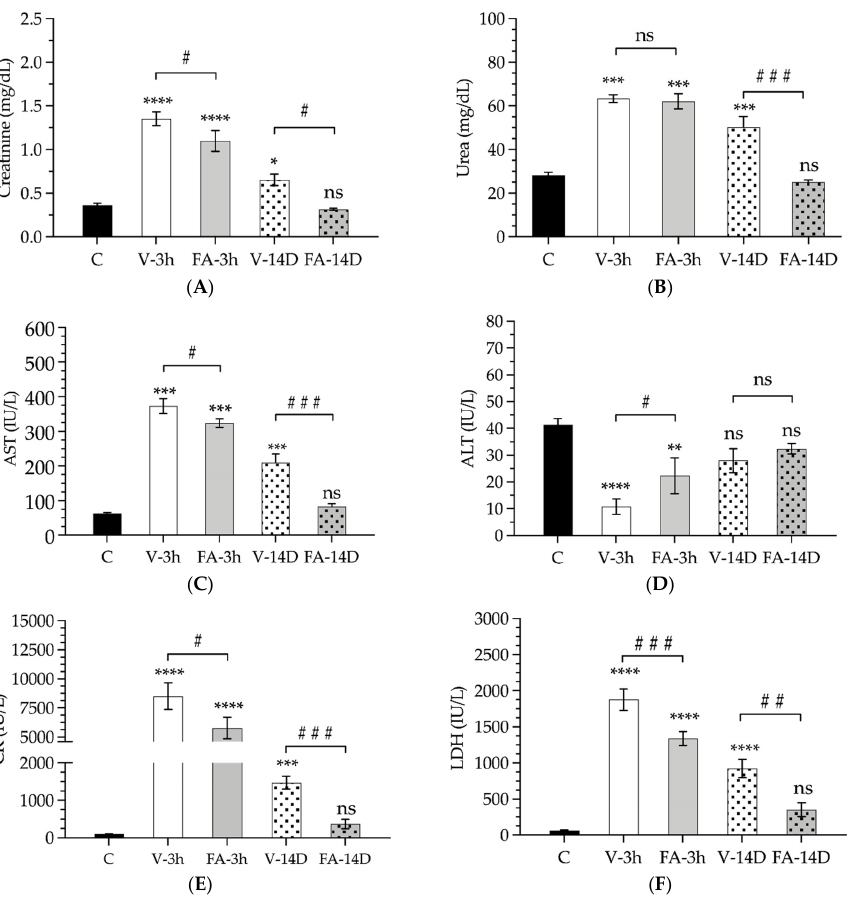
Figure 1. Enzyme and electrolyte levels detected in the serum samples collected from the control animals (C, black bar) or animals subjected to ischemia after a period of 3 h or 14 days of reperfusion and treated with folinic acid (FA-3h, smooth gray bars; FA-14D, smooth gray bars) or treated with saline (V-3h, smooth white bars; V-14D, smooth white bars): creatinine ( A ), urea ( B ), aspartate transaminase (AST) ( C ), alanine transaminase (ALT) ( D ), creatine kinase (CK) ( E ), lactate dehydrogenase (LDH) ( F ). Asterisks indicate statistically significant differences compared to the control. Pads indicate statistically significant differences between the untreated animals (white bars, vehicle) and those treated with folinic acid (grey bars, FA) after both 3 h (smooth pattern) and 14 days (dotted pattern). Data are represented as the mean and standard deviation. Statistical significance is accepted with a 95% confidence level (#, *: p < 0.05; ##, **: p < 0.01; ###, ***: p < 0.001; ****: p < 0.0001; ns: p > 0.05).